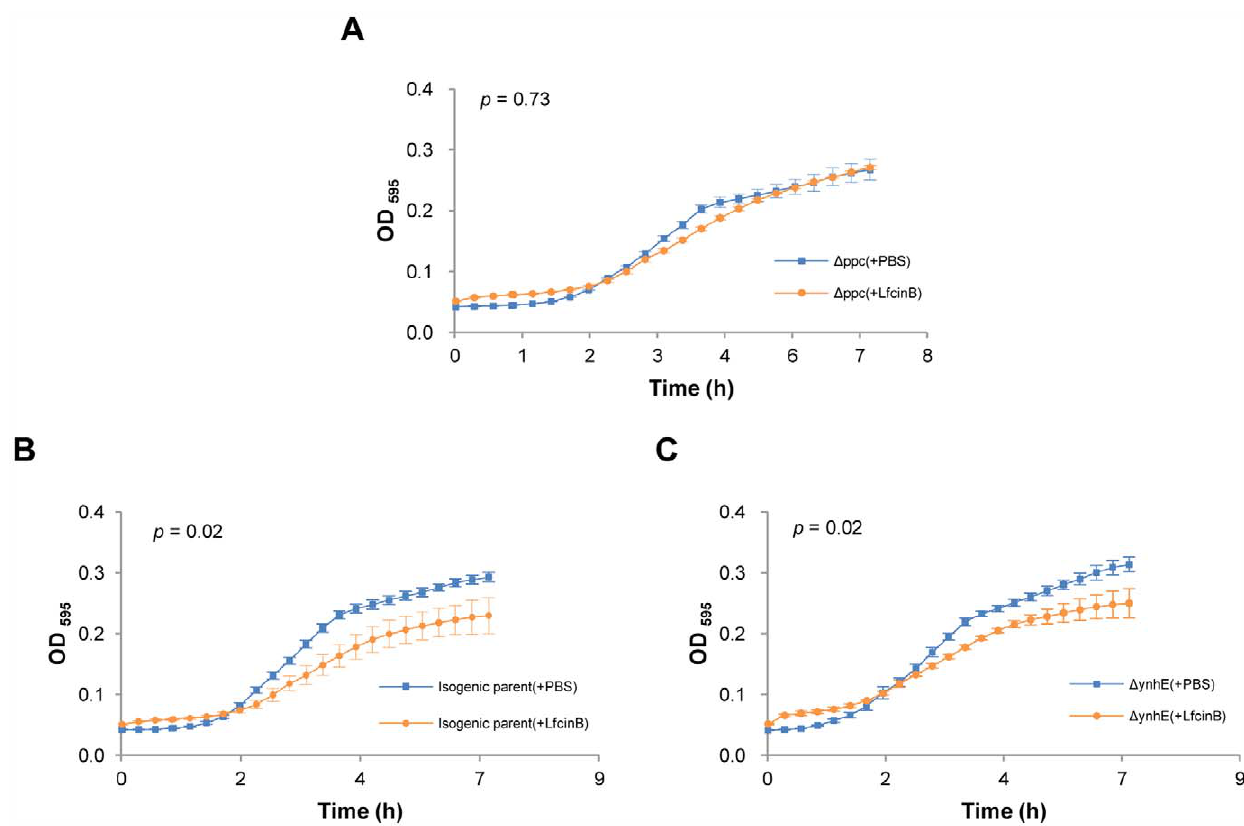
Figure 7. Comparison of the growth inhibition between knockout strains and the isogenic parent strain using knockout assays. We compared the effects of LfcinB on the growth of 16 E. coli knockout strains and the isogenic parent strain to examine which gene can escape from the effects of LfcinB. We used PBS (LfcinB dissolving buffer) as the negative control. A. D ppc with or without LfcinB have similar growth curves ( p . 0.05). B. The isogenic parent strain has a significant difference ( p , 0.05) between treatment with or without LfcinB. C. D ynhE, representing the other 15 knockout strains ( p , 0.05), is similar to the isogenic parent strain. These results indicate that D ppc avoided the LfcinB attack.